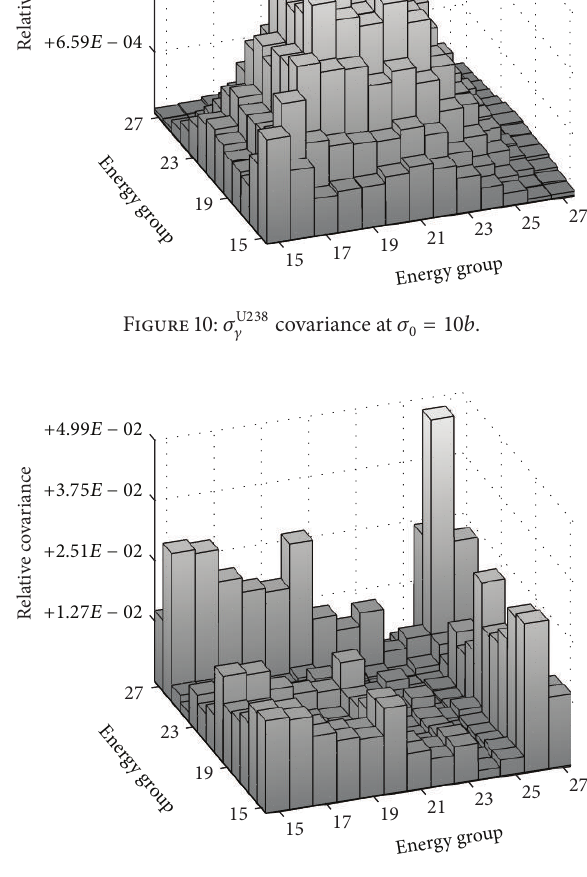
Figure 14: 𝜎 U 238 𝑒 covariance at 𝜎 0 = 10𝑏 .